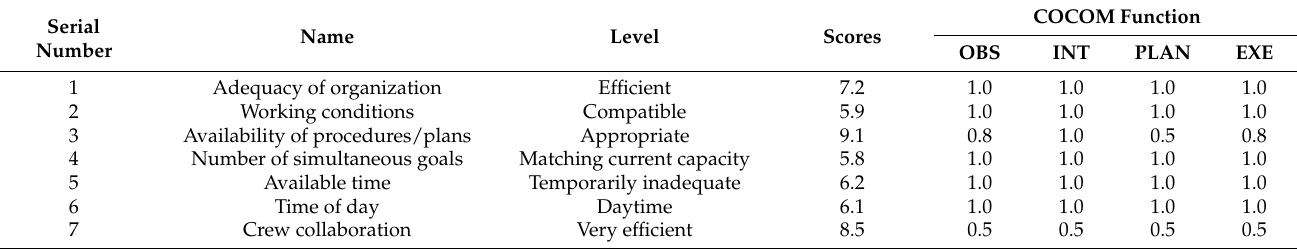
Table 9. Questionnaire summary of CPCs factor weights.